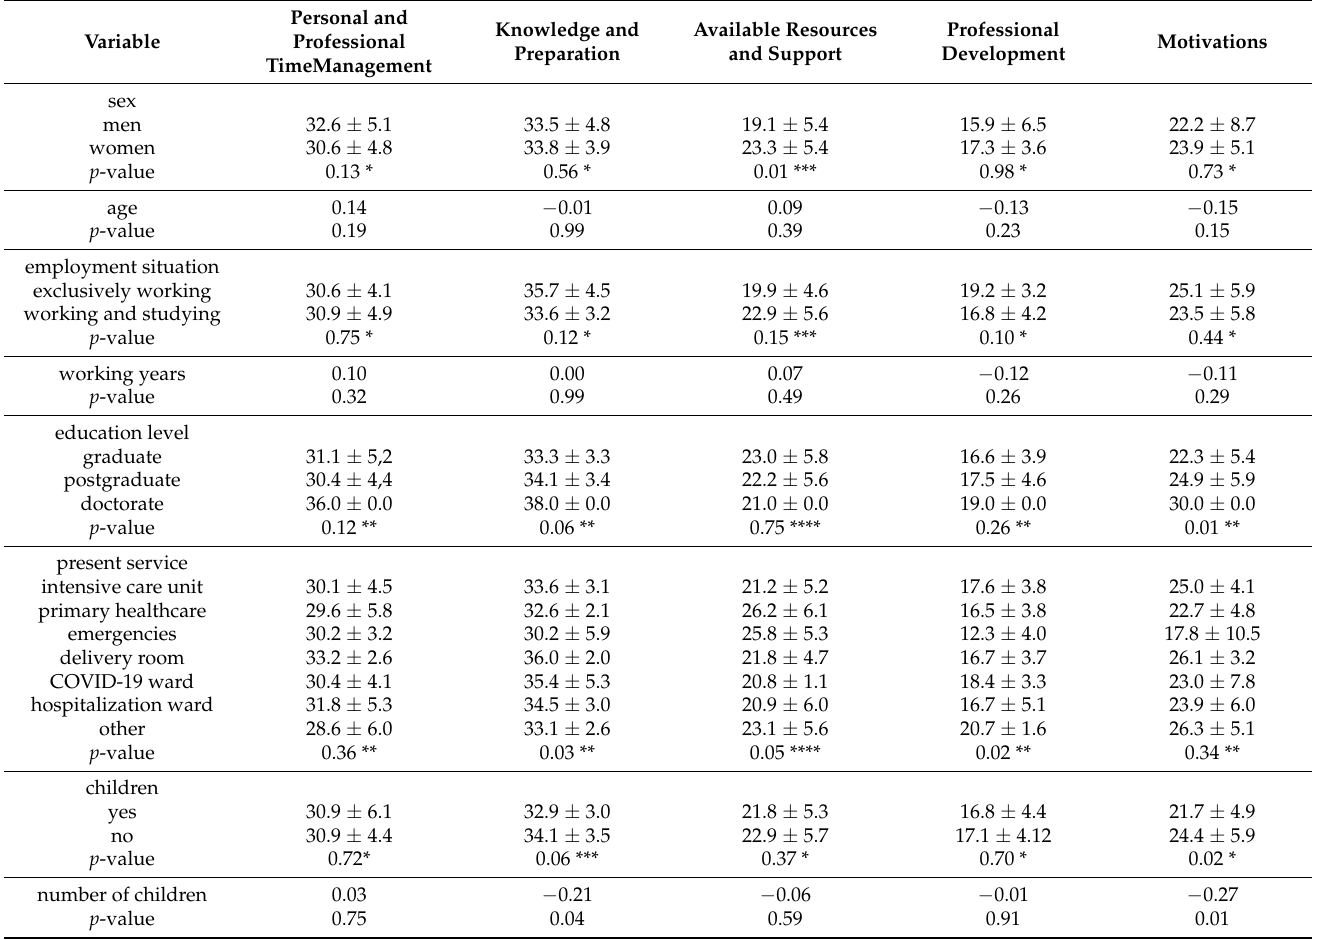
Table 3. Bivariant analysis of the domains, regarding demographical features of the